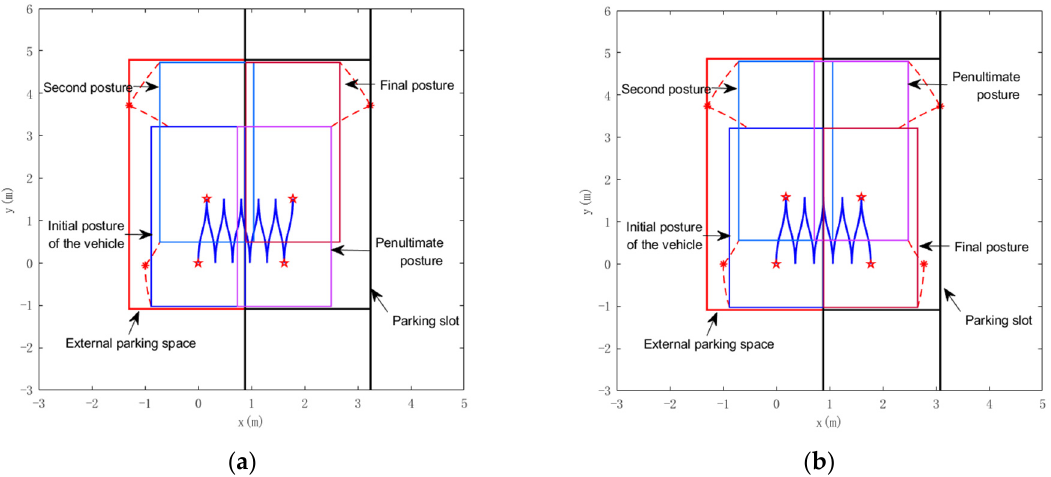
Figure 7. Simulation of the parking for two situations: ( a ) situation1; ( b ) situation 2.